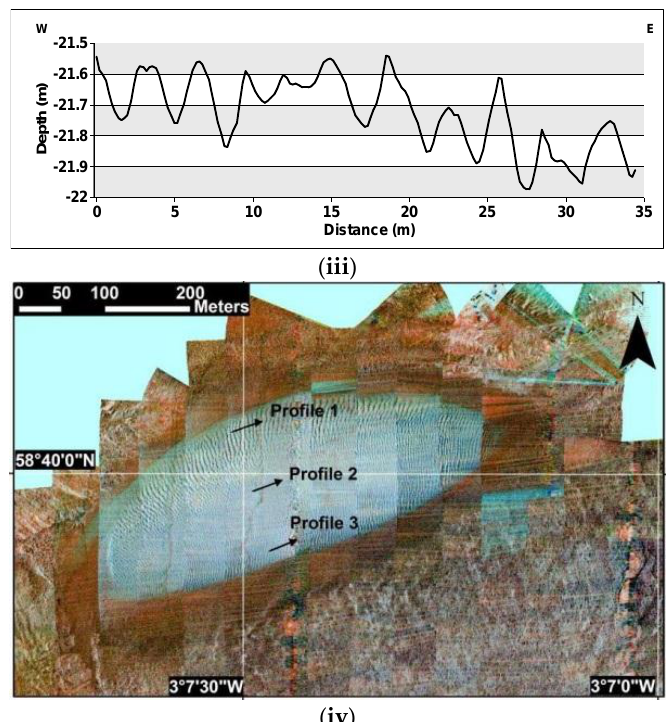
Figure 5. ( iv ) Position of dune profiles along three sections on the oval dune overlain on survey 2 (June 2015); Profile bathymetric data from multi-beam data collected during the ebb phase (2009, 3( i ) Profile 1 shows sand dunes with 40 cm amplitude and up to 7 m wavelength; ( ii ) Profile 2 showing small dunes in the centre of the oval dune, Amplitudes of ~10 cm and 1–2 m wavelength; ( iii ) Profile 3 showing smaller sand dunes on the southern edge of the oval sediment bank. Amplitudes of 20 cm and wavelength of 2–3 m